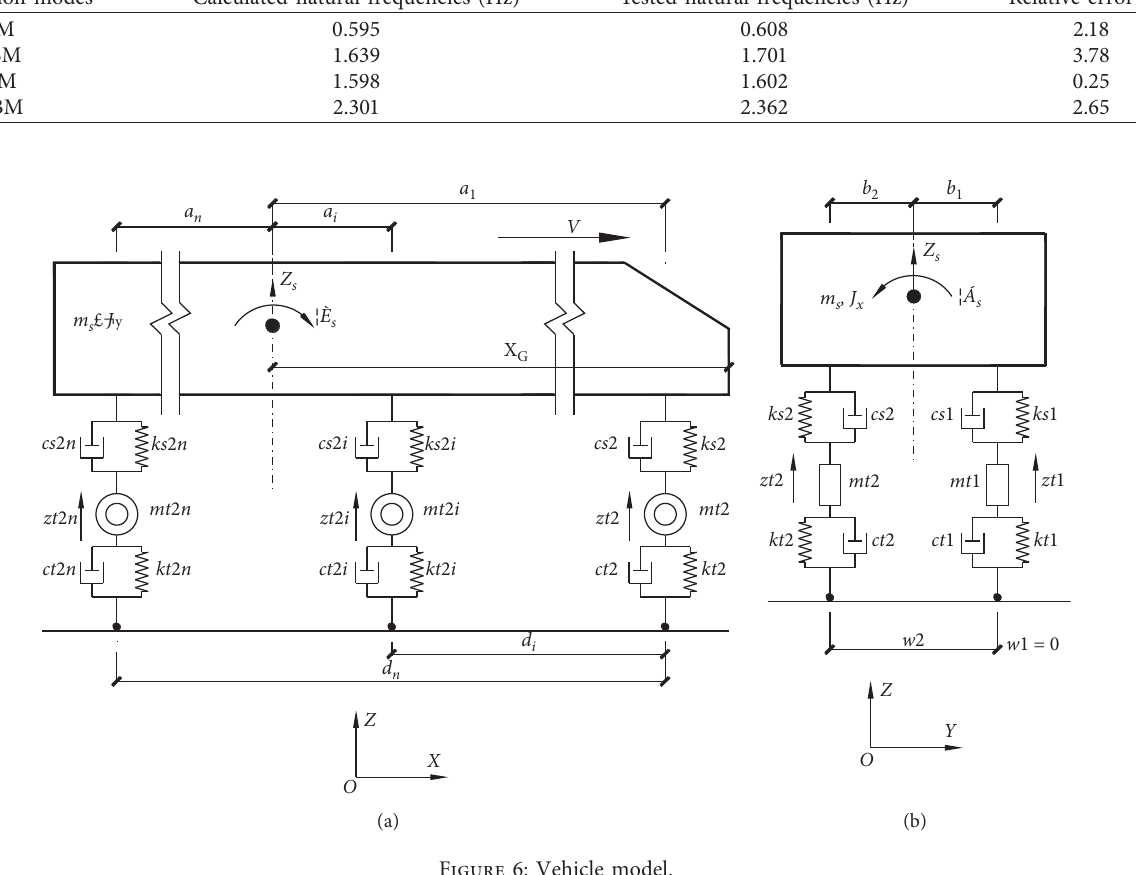
Figure 5: Modal analysis results: (a) first-order transverse bending mode (1 st TBM); (b) second-order transverse bending mode (2 nd TBM); Table 2: Dynamic characteristics of the bridge. Vibration modes